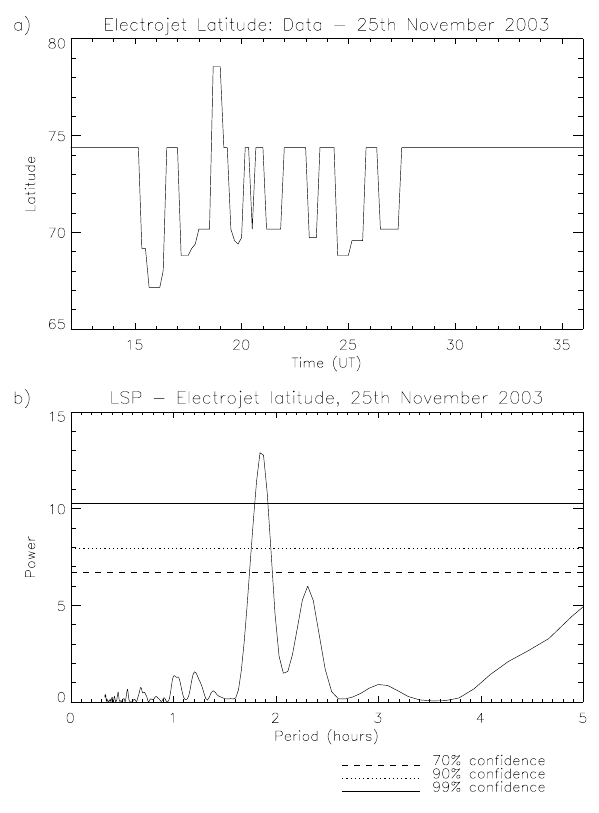
Fig. 13. Positions of the electrojets (a) and periodogram (b) from IMAGE B z data, from the 25 November 2003.